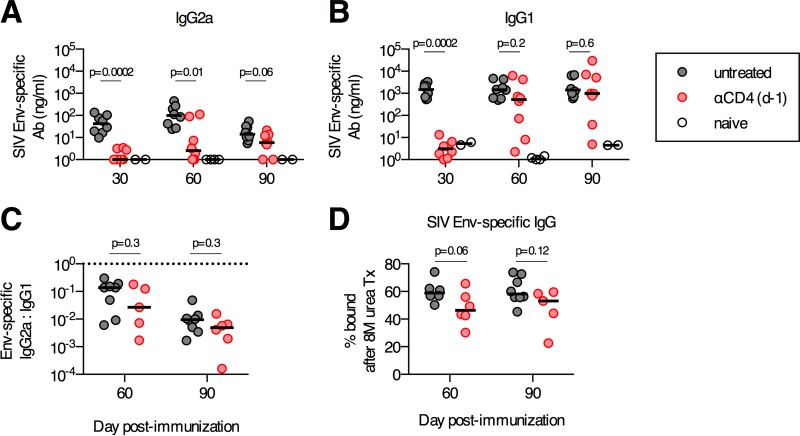
Transient depletion of CD4+ T cells at priming does not alter the isotype distribution or the antigen-binding avidity of delayed antibody (Ab) responses. C57BL/6 mice were depleted of CD4+ T cells or left untreated and immunized intramuscularly with 1010 vp of Ad26-SIV Env. (A and B) Concentrations of serum SIV Env-specific IgG2a (A) and IgG1 (B). (C) Ratios of SIV Env-specific IgG2a to IgG1 serum antibody titers. The horizontal dotted line denotes a ratio of 1. (D) Avidity of SIV Env-specific serum antibodies as determined by a urea disruption assay. Each dot represents an individual mouse, and the medians are indicated by the line (n = 5 to 8/group pooled from two experiments).